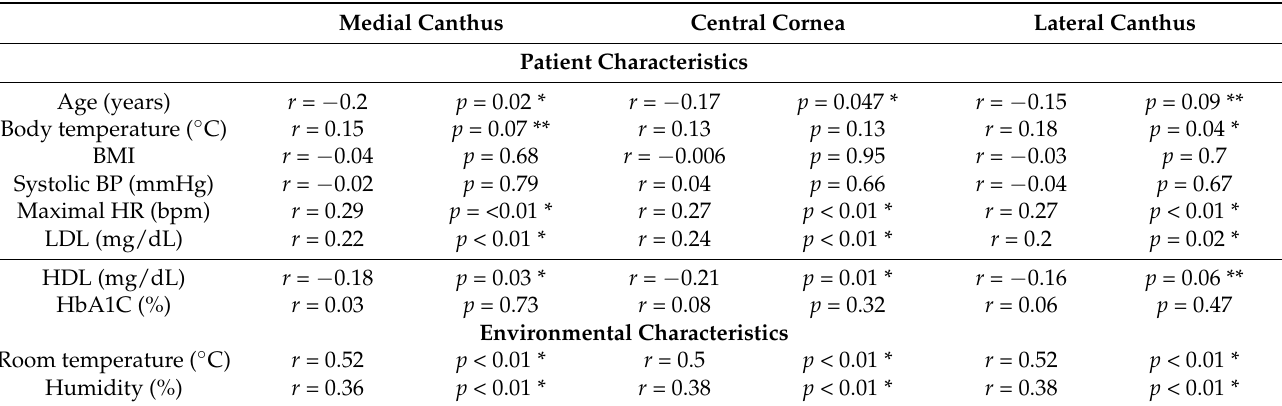
Table 4. Patient and environmental characteristics correlations with